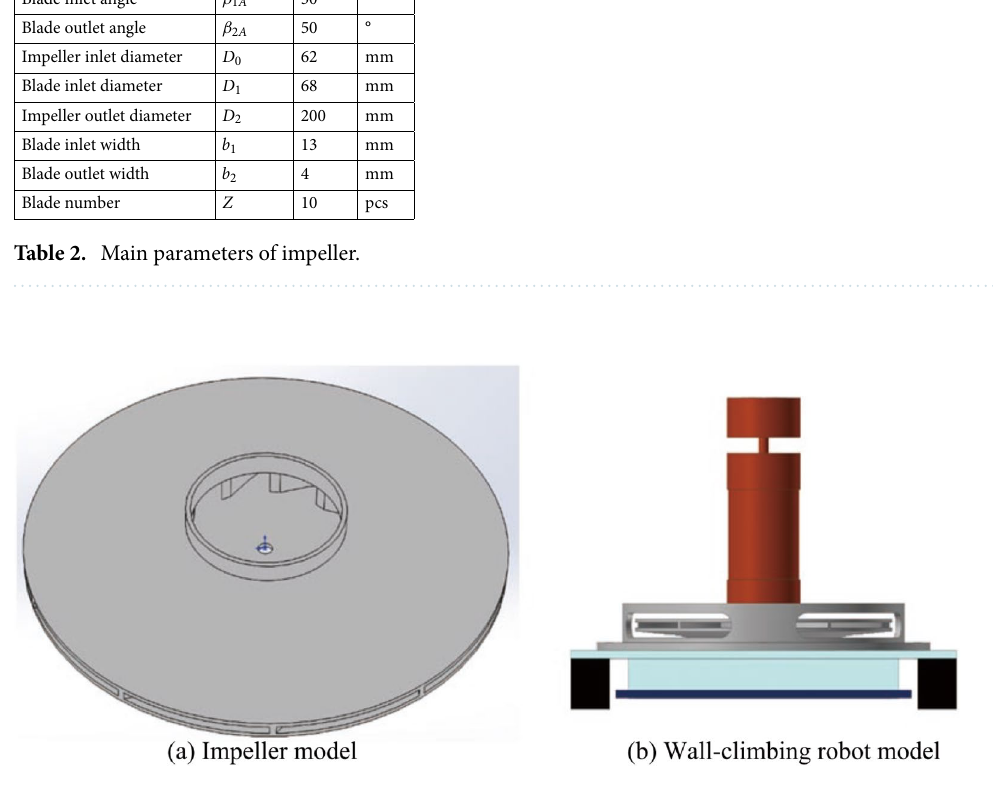
Figure 6. Wall-climbing robot and its impeller